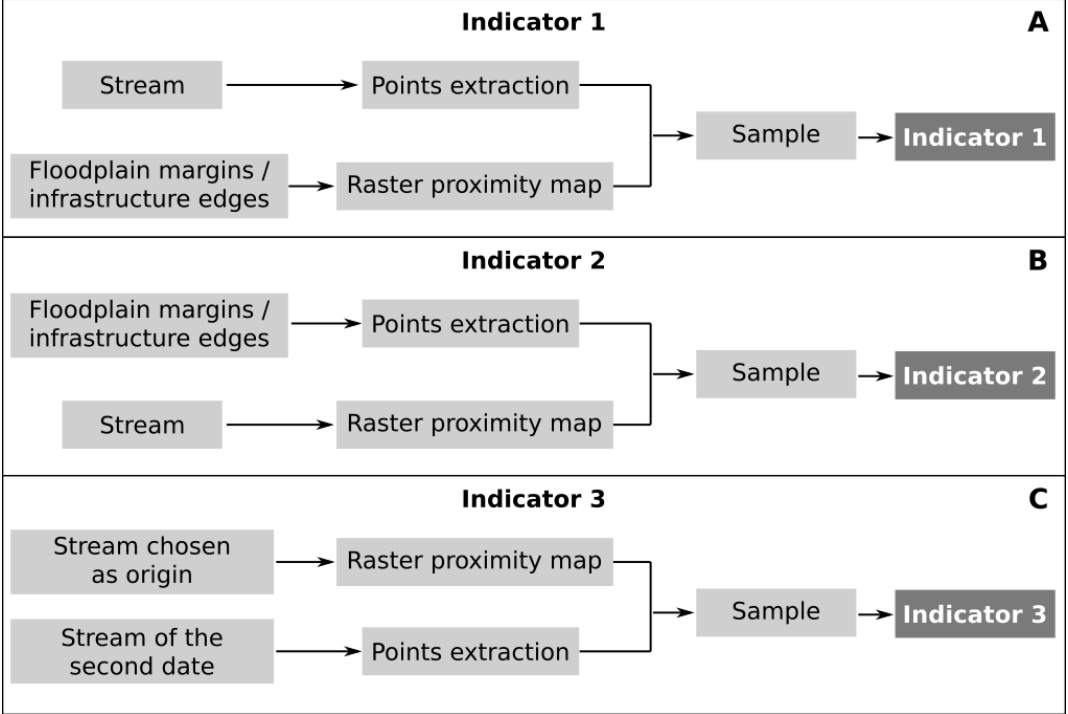
Figure 5. Workflow for the calculation of the indicator 1 ( A ), 2 ( B ) and 3 ( C ). (i) Indicator 1: Distance from Active Channel to Stakes or Floodplain Margins. This first